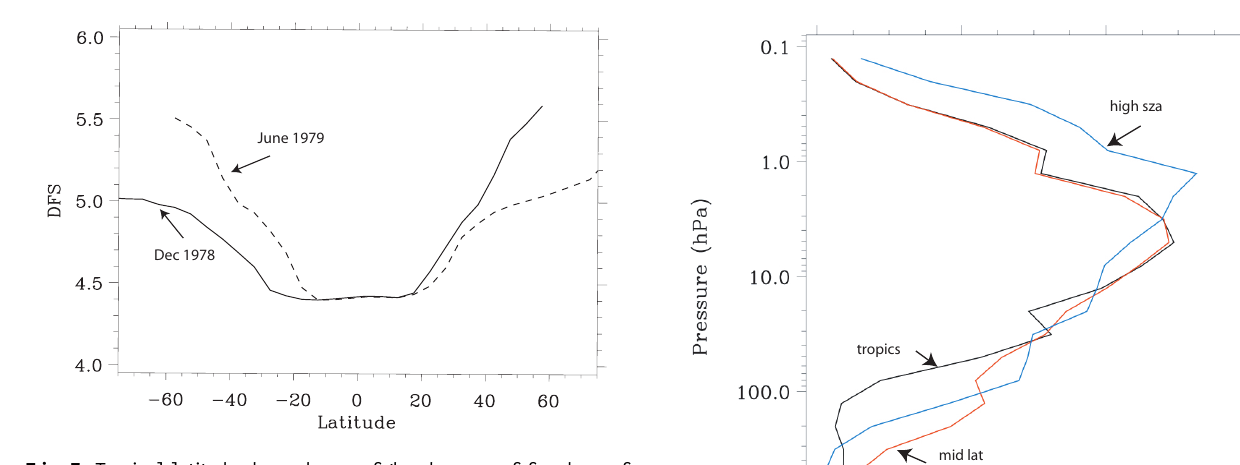
Fig. 7. Typical latitude dependence of the degrees of freedom of Figure 7. Typical latitude dependence of the Degrees of Freedom of Signal (DFS). signal (DFS). Variations in DFS are partly caused by change in solar Variations in DFS are partly caused by change in solar zenith angle that changes the zenith angle that changes the number of wavelengths used in the number of wavelengths used in the algorithm from a minimum of 6 to a maximum of 9, and partly by change in tropopause height, the higher the ozone density peak lower the algorithm from a minimum of 6 to a maximum of 9, and partly by DFS. Both effects combined produce smallest DFS in the tropics. change in tropopause height: the higher the ozone density peak, the lower the DFS. Both effects combined produce smallest DFS in the tropics.